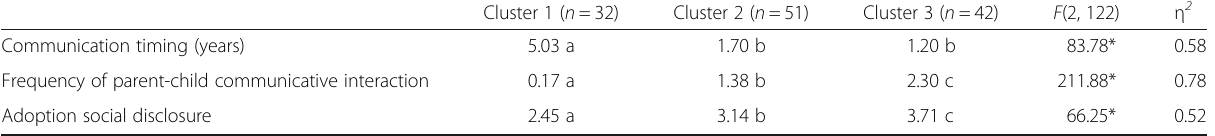
Table 2 Adoption Communication: Cluster